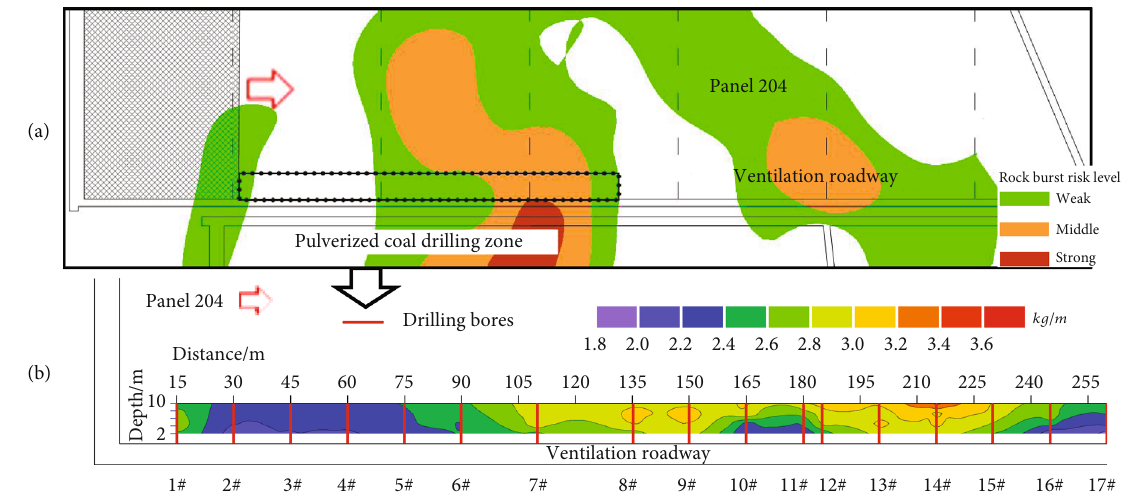
Figure 9: Rock burst risk zones on 30 April and drilling bits results on 1-2 May